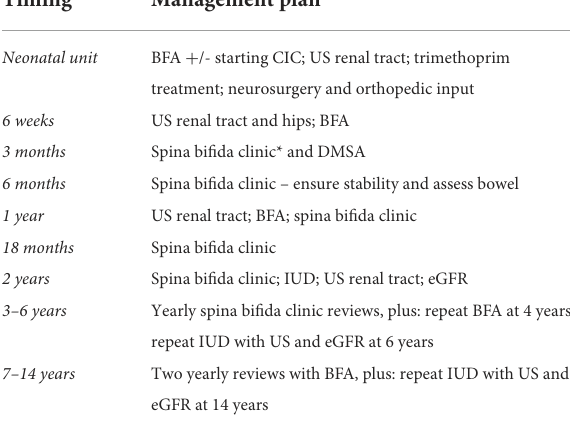
TABLE 1 Protocol used for the management of spina bifida patients with neuropathic